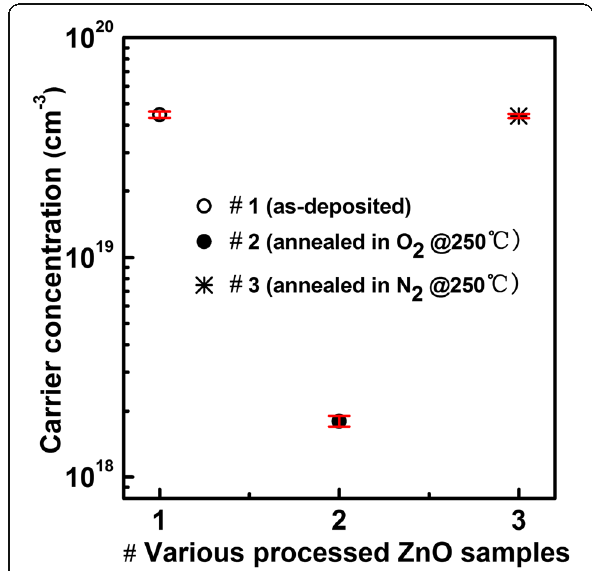
Fig. 6 The carrier concentrations of the as-deposited ZnO film and those annealed under different